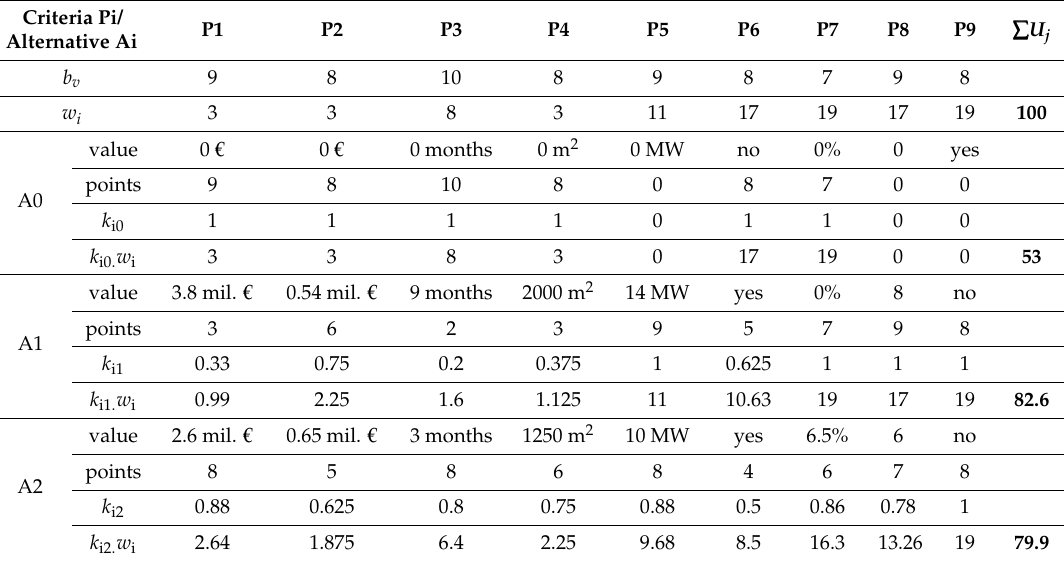
Table 3. Index coefficient